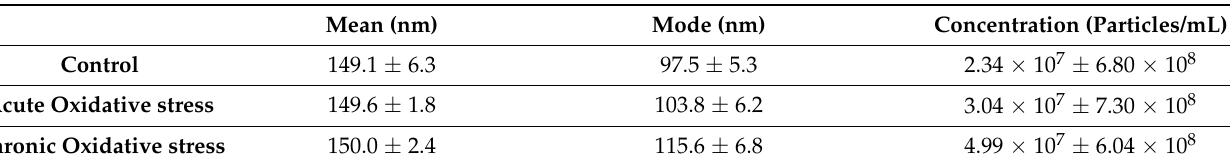
Table 1. Characterization comparison of NPCE-derived exosomes following acute and chronic oxidative stress. Mode Analyzed by Nanoparticle Track- ing Analysis (NTA). Data Represent the